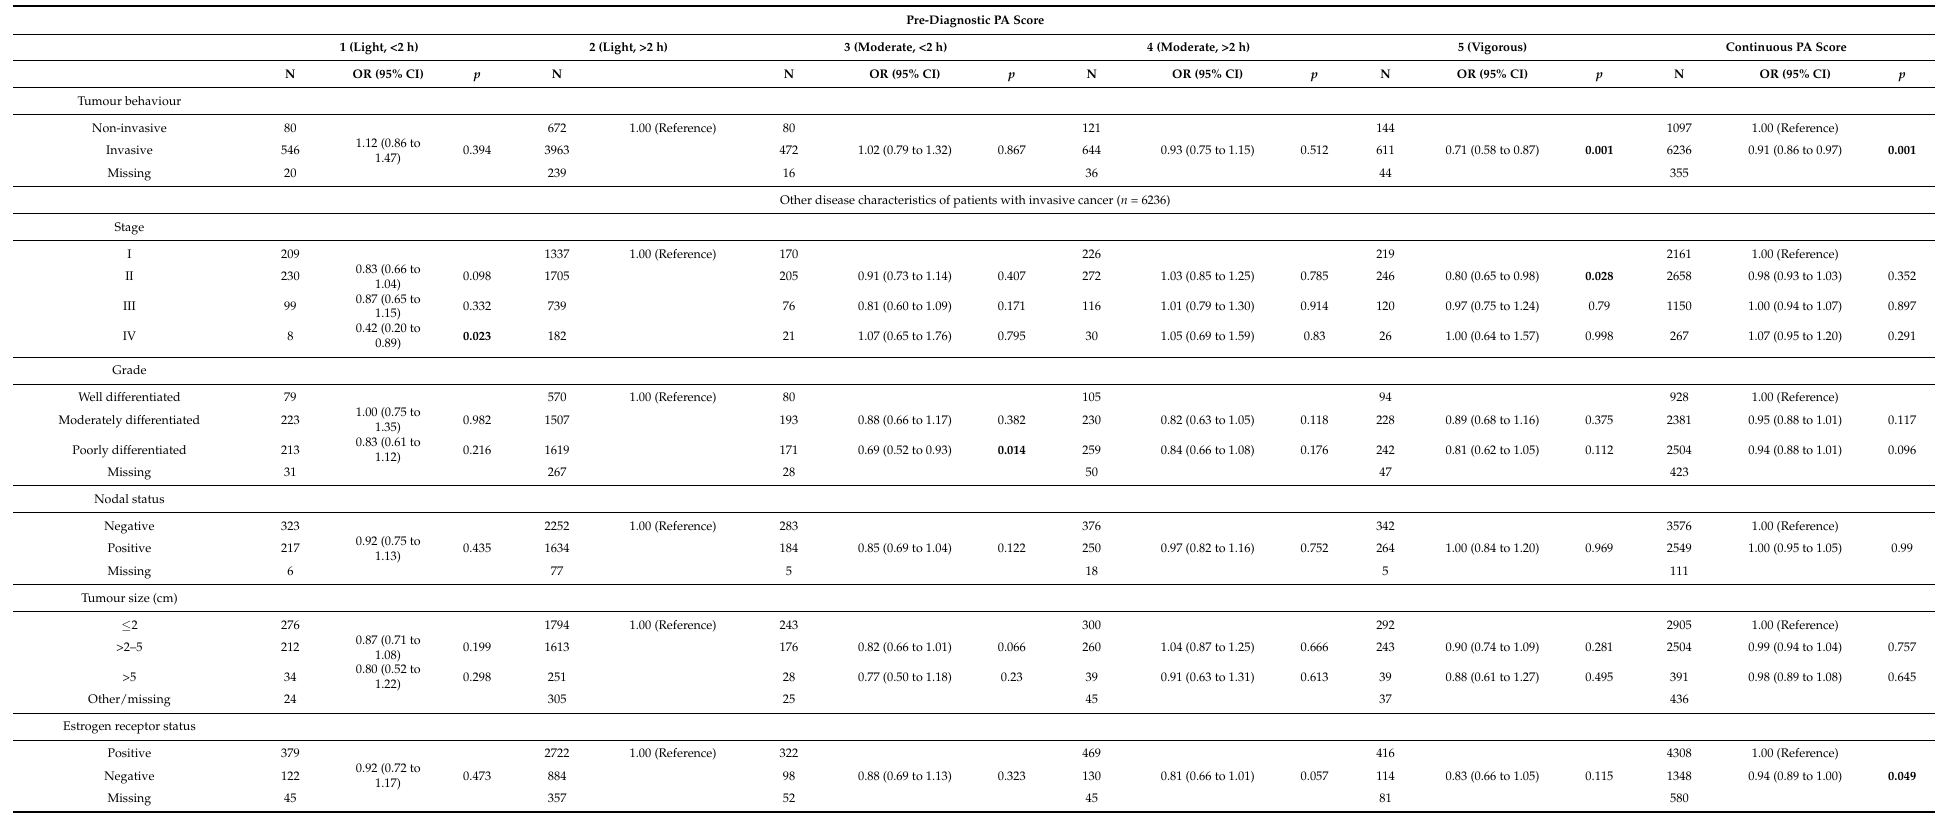
Table 2. Associations between pre-diagnostic physical activity (PA) score and disease characteristics adjusted for age at diagnosis, body size one year prior to diagnosis, ethnicity, and recruitment site ( n = 7688). Odds ratios (OR) and 95% confidence intervals (CI) were estimated using multinomial regression. p indicates p -value obtained from the Wald test. Results in bold indicate p ≤